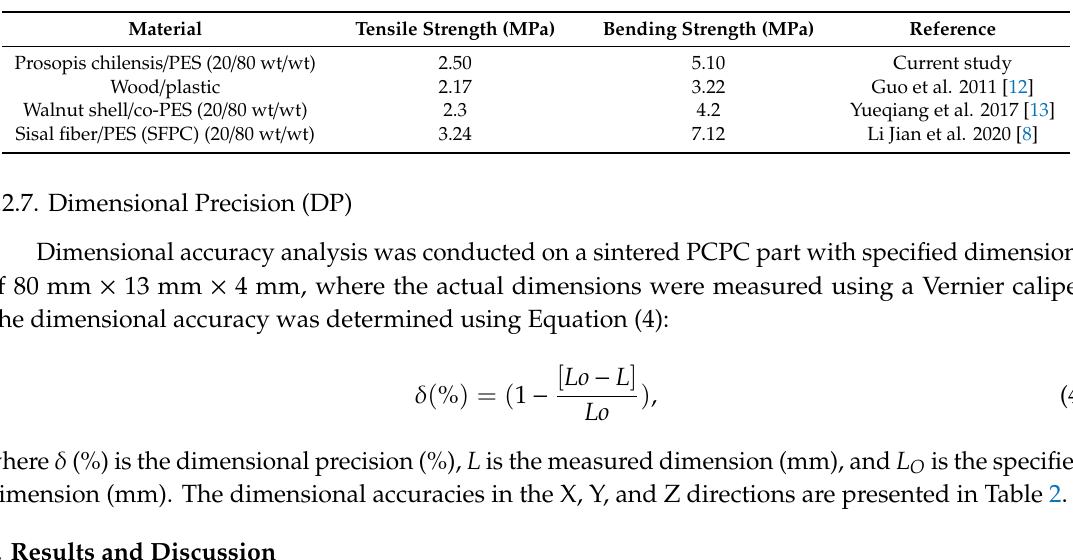
Comparison of the mechanical properties composite materials produced under the same